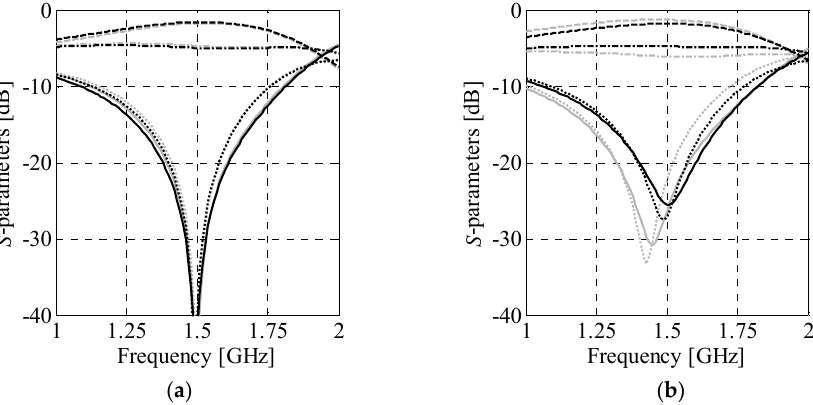
Figure 11. BLC responses vs. frequency at various stages of the design process: ( a ) low-fidelity model-based characteristics at y 0 (gray) and y 2 * (black) and ( b ) EM-based responses of assembled coupler at y 2 * (gray) and y * (black). The characteristics are marked as follows: S 11 (–), S 21 (– –), S 31 (–·), S 41 (···).